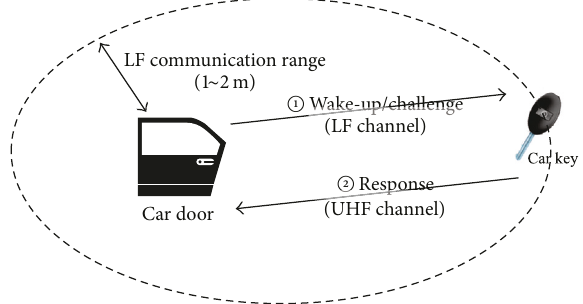
Figure 1: Authentication flow for the PKES